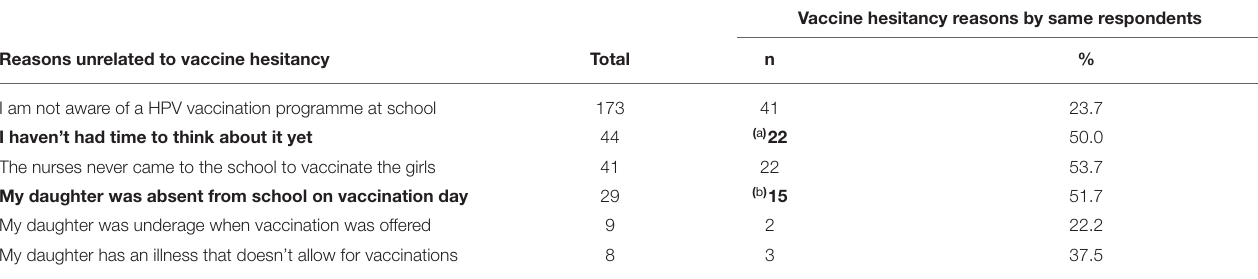
TABLE 4 | Frequency distribution of reasons unrelated to vaccine hesitancy given together with reasons related to vaccine hesitancy by the same